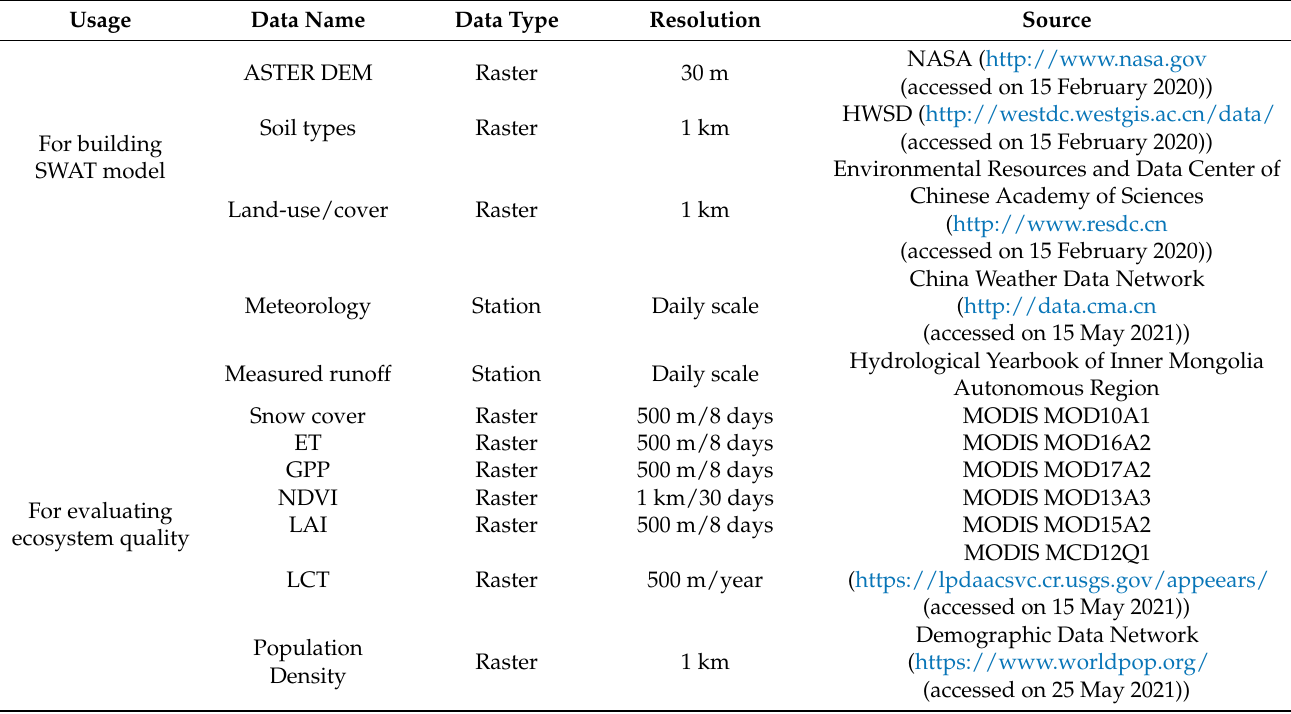
Table 1. Introduction to basic data